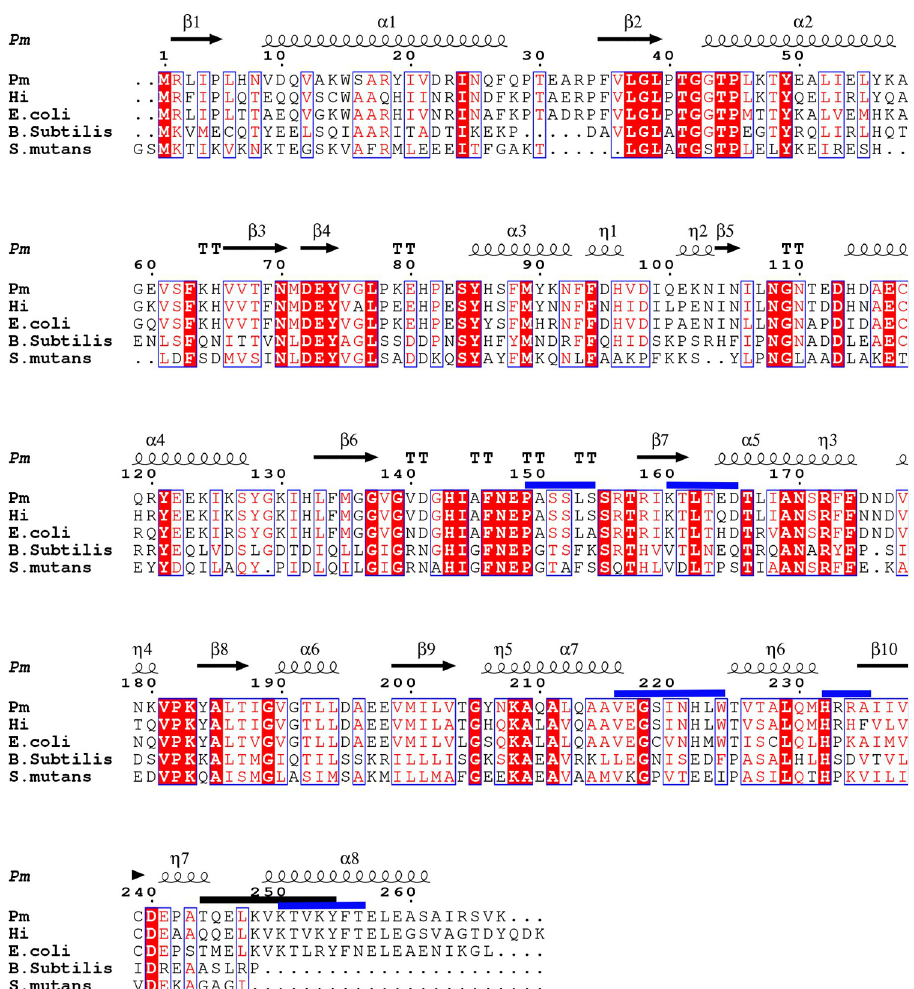
Fig 1. Multiple sequence alignment of NagB from E . coli , P . multocida , H . influenza , B . subtilis and S . mutans generated using ESPript 3.0. The secondary structural elements are marked based on the structure of Pm-NagB. The residues marked in black bars are residues in the dimer interface. The residues marked in blue bars are the residues in the interface of subunits in the trimer interface.